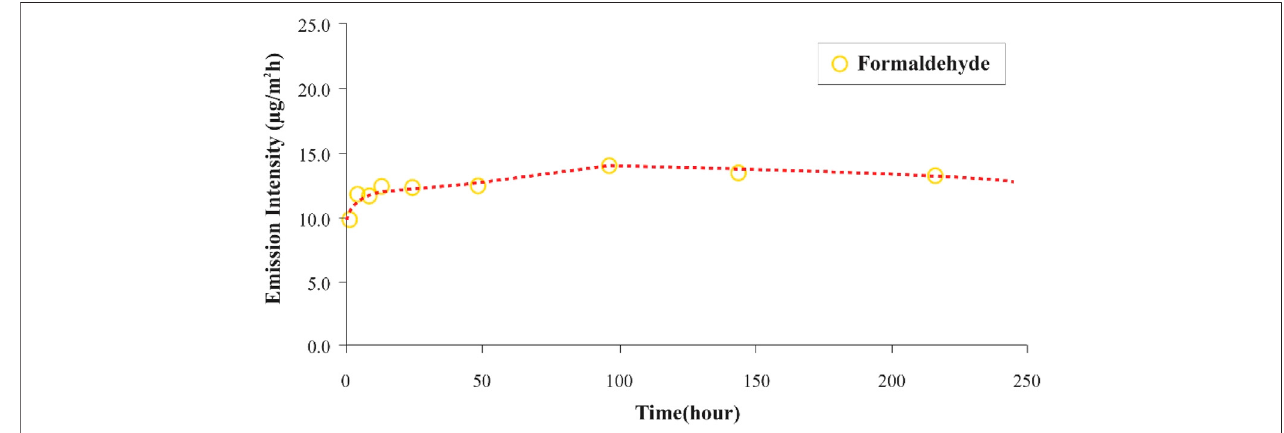
FIGURE 9 | Emission pattern of CH 2 O from fl ooring.